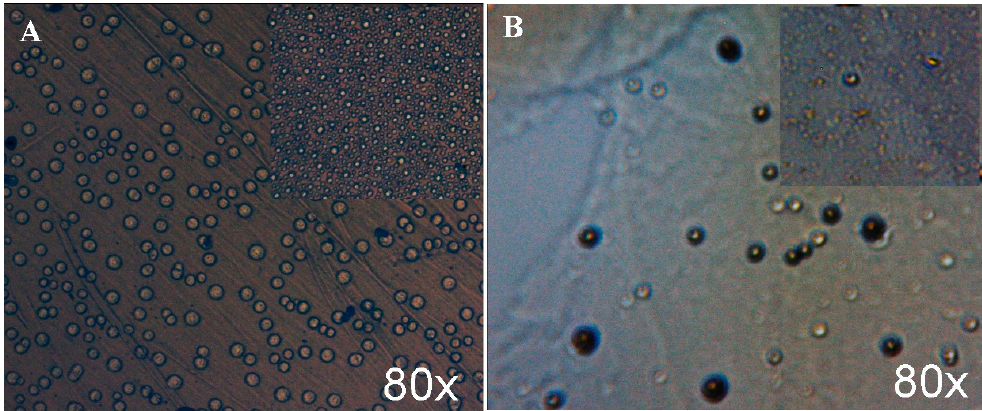
Figure 6. Optical microscope images for the surface morphology of prepared membranes: CA/PEG ( A ) and CA/PEG/CHI-Ag ( B ).